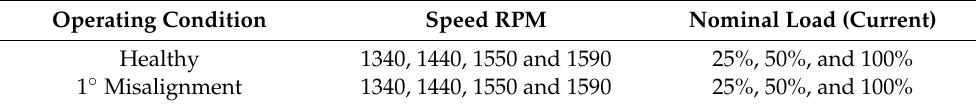
Table 3. Summary of the machine operating